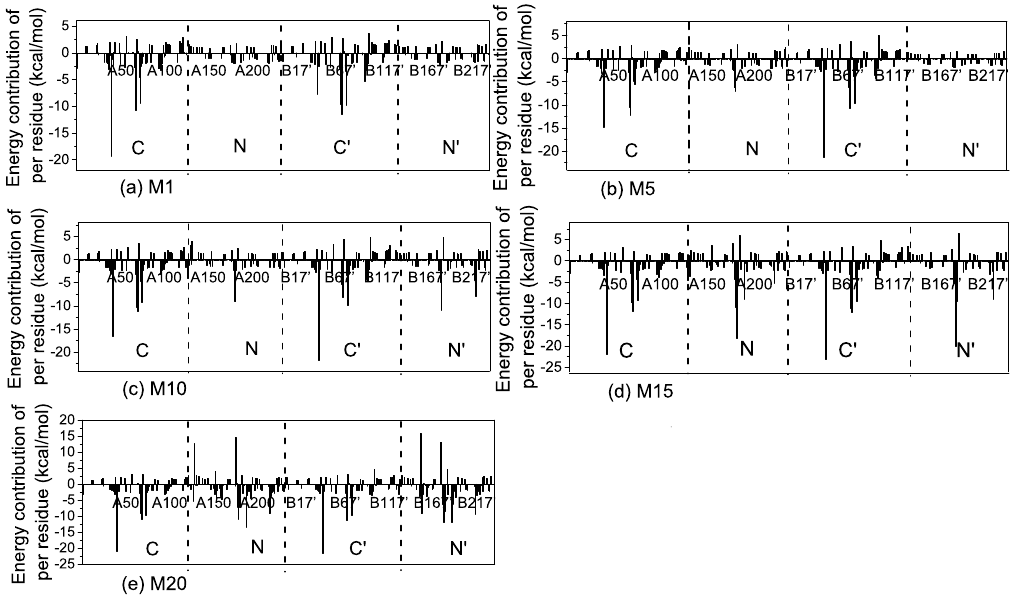
Figure 3. The interaction spectra of EndoMS/NucS with the mismatched dsDNA for ( a ) M1, ( b ) M5, ( c ) M10, ( d ) M15, and ( e ) M20. The interaction spectra of the other systems can be found in Figure S1.